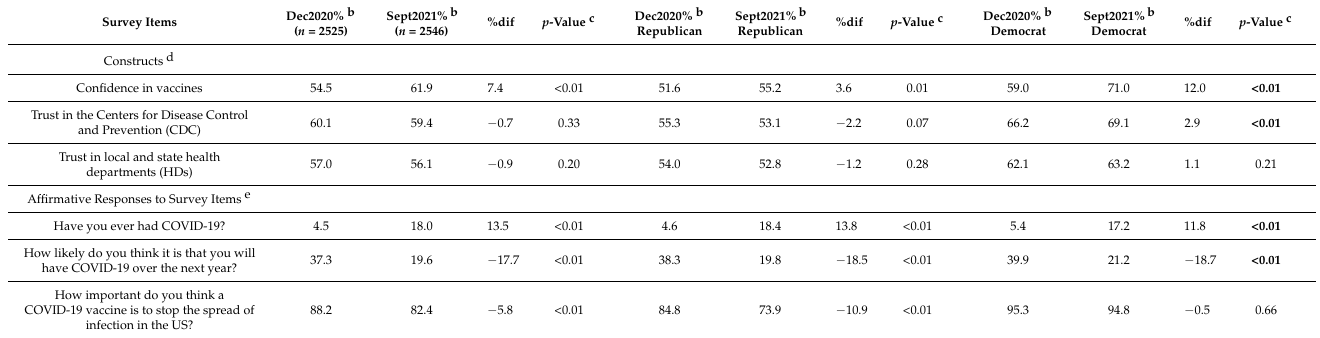
b Column percentages (of corresponding sample), weighted according to survey weights to achieve national representativeness. c significance level of alpha = 5%; bold indicates statistical significance ( p < 0.05). d Construct scales combine scores for each relevant survey item (reversing negative items) and divide by maximum